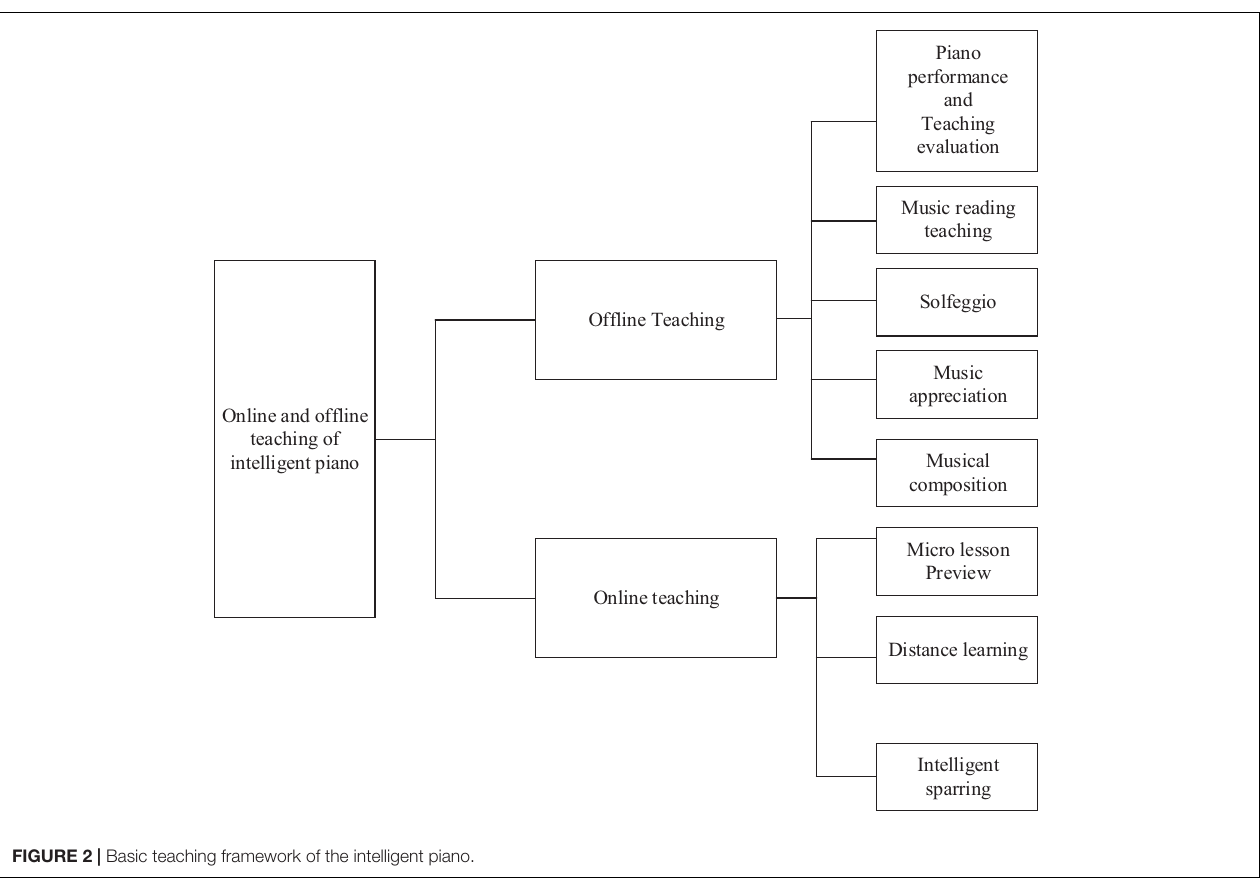
FIGURE 2 | Basic teaching framework of the intelligent piano.